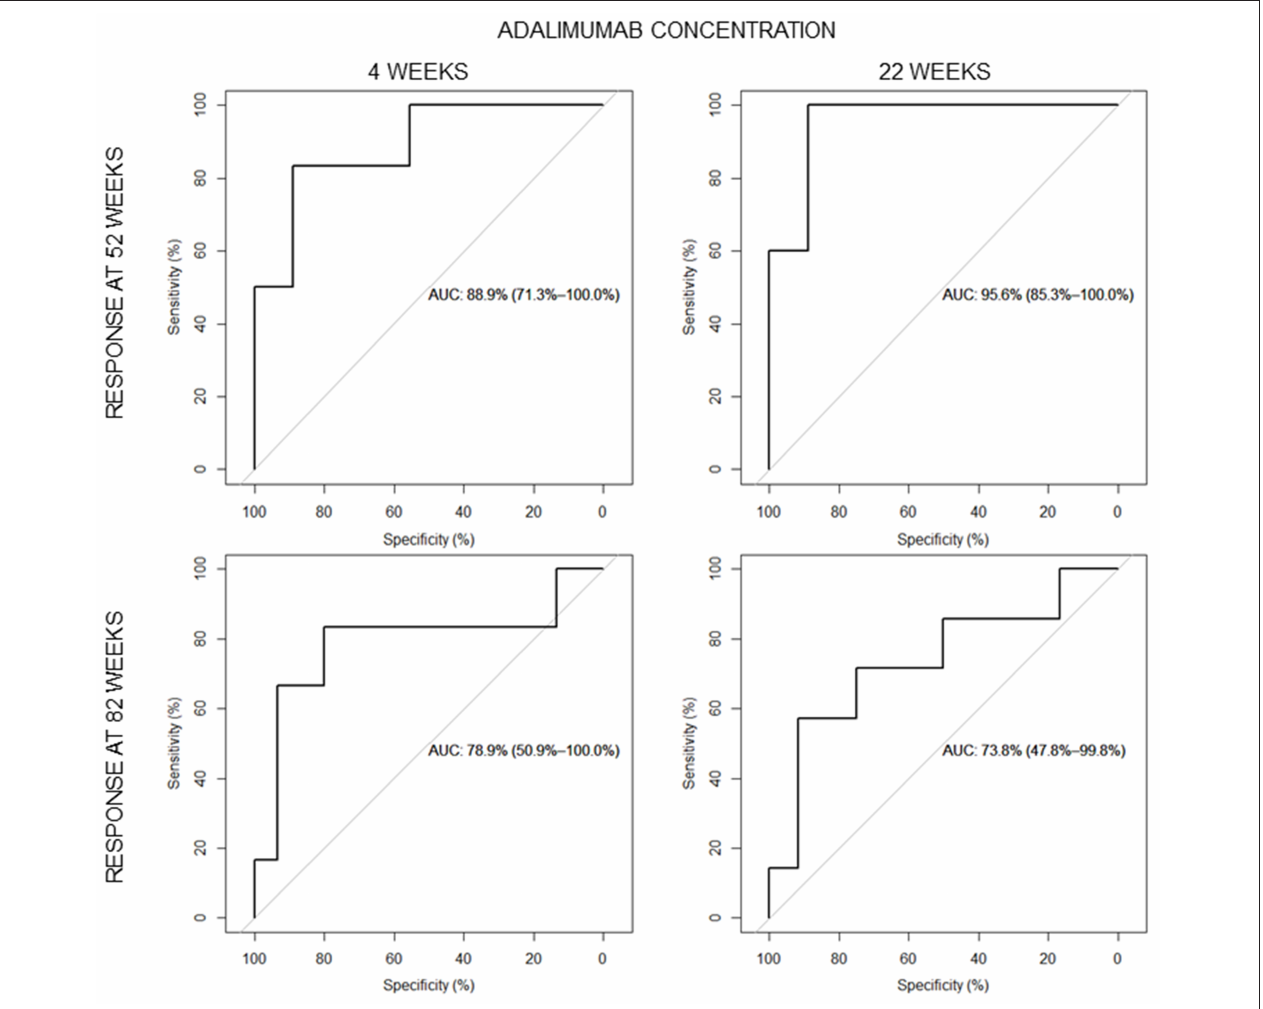
FIGURE 3 | Areas under the receiver operating characteristic (ROC) curves for the serum adalimumab quantification at the end of induction and week 22 for clinical disease activity at 52 (above) and 82 weeks (below).